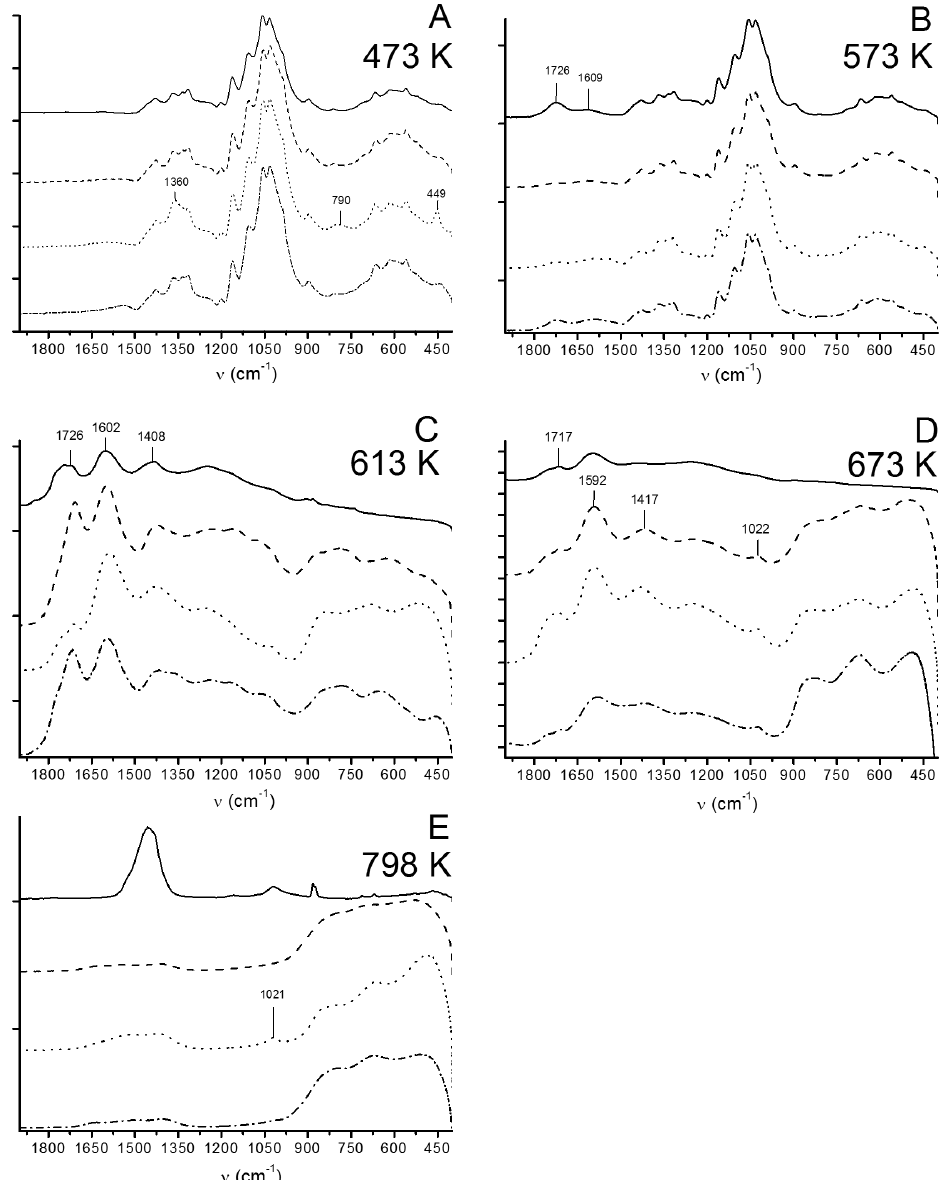
Figure 8. ATR-FTIR spectra for thermal decomposition of fully bleached Kraft